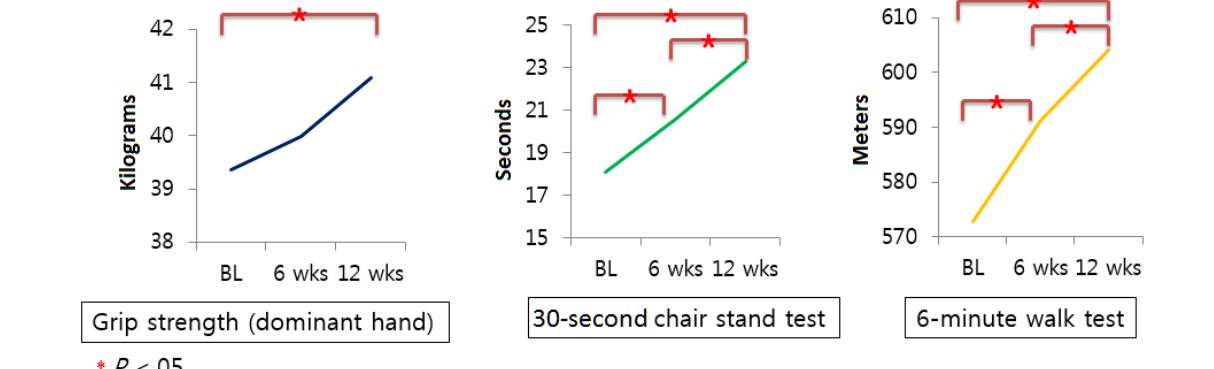
Figure 3. Changes in physical fitness measures. BL: baseline; wks: weeks.